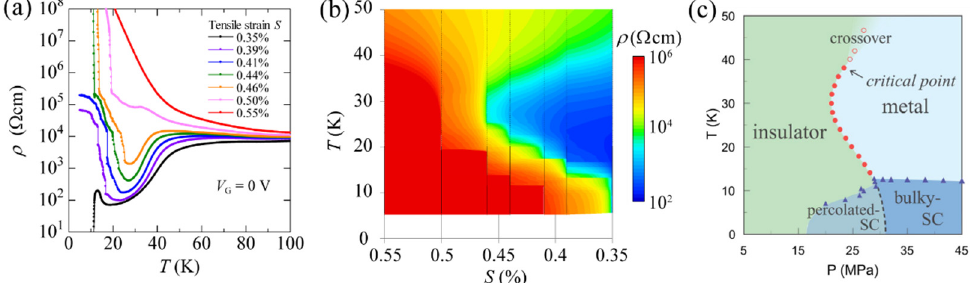
Figure 5. ( a ) Resistivity vs. temperature plots under different tensile strains at gate voltage 𝑉 (cid:2891) = 0 V, and ( b ) contour plots of the resistivity data. ( c ) Pressure-temperature phase diagram of bulk κ -Cl. Reproduced with permission from [12].